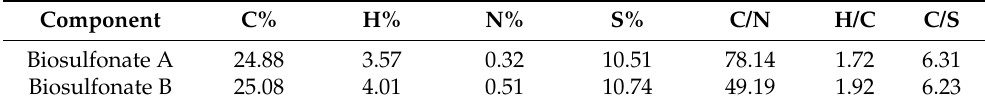
Table 1. A 4500A multifunctional pulverizer processed the paper powder with a speed of 32000 rpm and a pulverization degree of 250–350 mesh. Table 1. Composition of biosulfonates A and